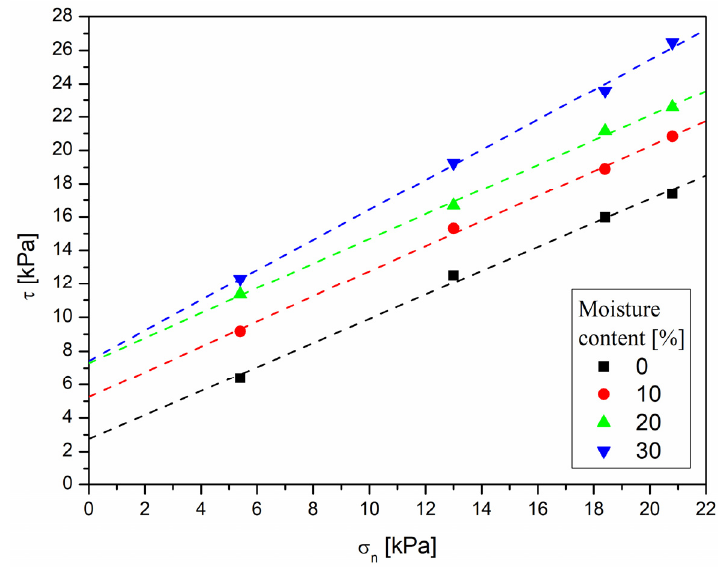
Figure 6. Effect of moisture content on yield loci for hard coal.